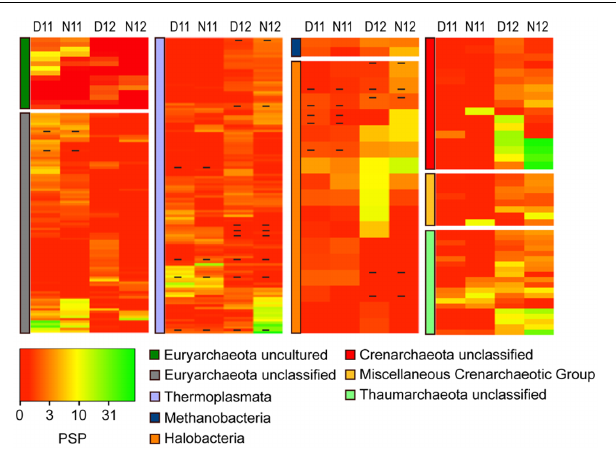
FIGURE 3 | Heatmap analysis of OTU PSP for each archaeal class for day and night samples across years (D11, Day 2011; N11, Night 2011, D12, Day 2012; N12, Night 2012). The heatmap color represents the extent of protein synthesis potential (PSP) as measured by rRNA: rDNA ratio for each OTU. Square colors shifted toward brighter green indicate higher PSP of that OTU. Dash within squares indicates abundant OTUs. Standard deviations are located in Supplemental Table S3.